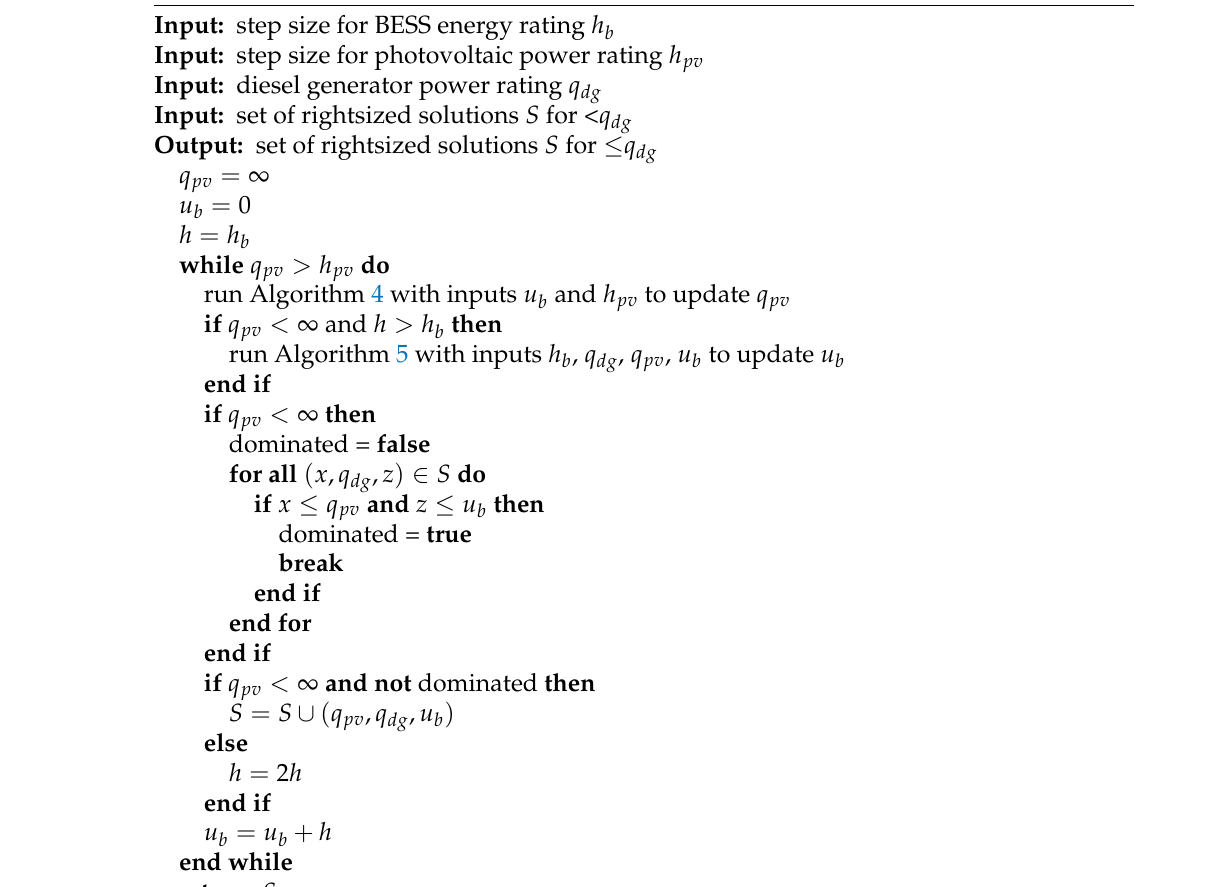
Algorithm 6 Identification of all rightsized designs < = dg .